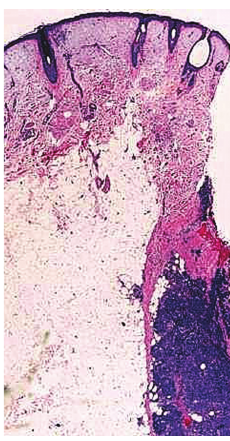
Figure 1: Dermal solar degeneration and dark tumor nodule in the subcutaneous tissue.